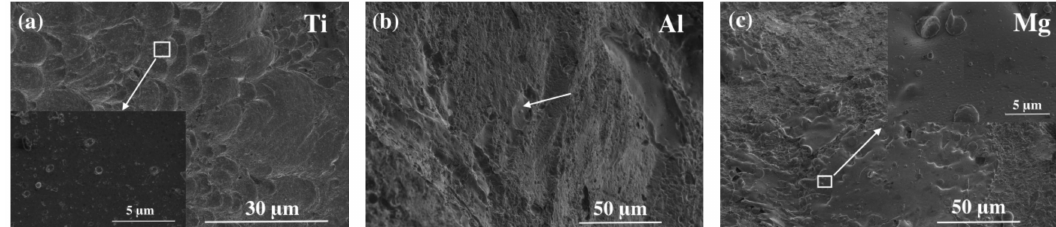
Figure 4. SEM micrographs of the crater for sample I. ( a ) Ti-matrix; ( b ) Al-matrix; ( c )